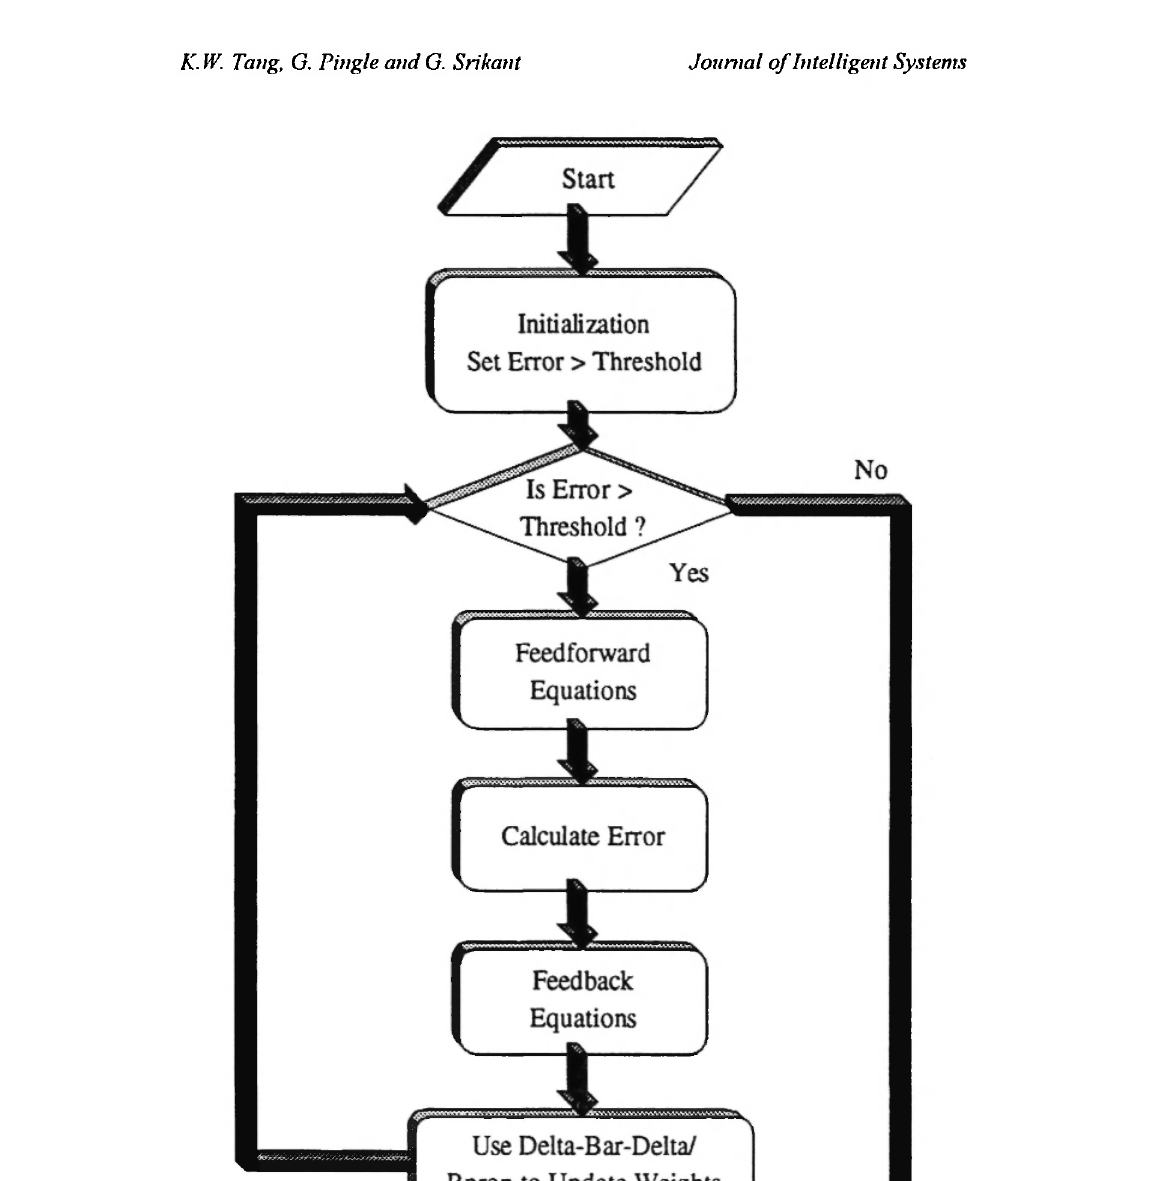
Fig. 3: A flow-chart for training an